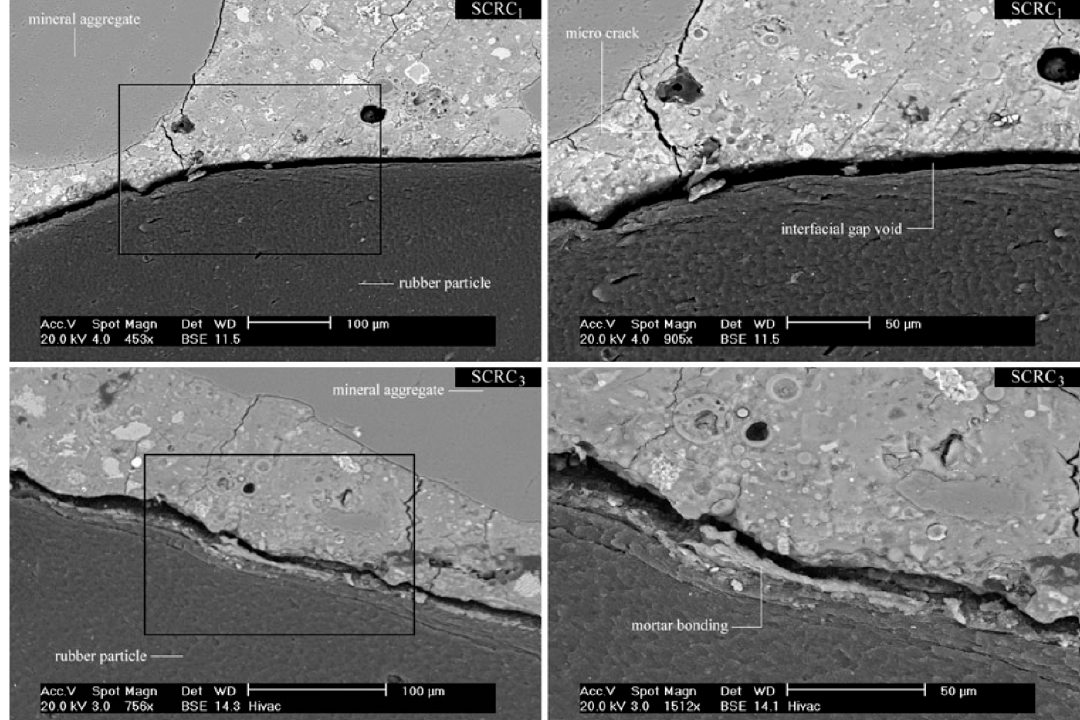
Figure 11. Interfacial bonding between cement paste and rubber aggregate without pre-treatment (SCRC1) and with pre-coating with mortar—(SCRC3) [34]. Reproduced with permission from K. B. Najim and M. R. Hall, Crumb rubber aggregate coatings/pre-treatments and their effects on interfacial bonding, air entrapment and fracture toughness in self-compacting rubberised concrete (SCRC); published by Elsevier, Materials and Structures, 2013.